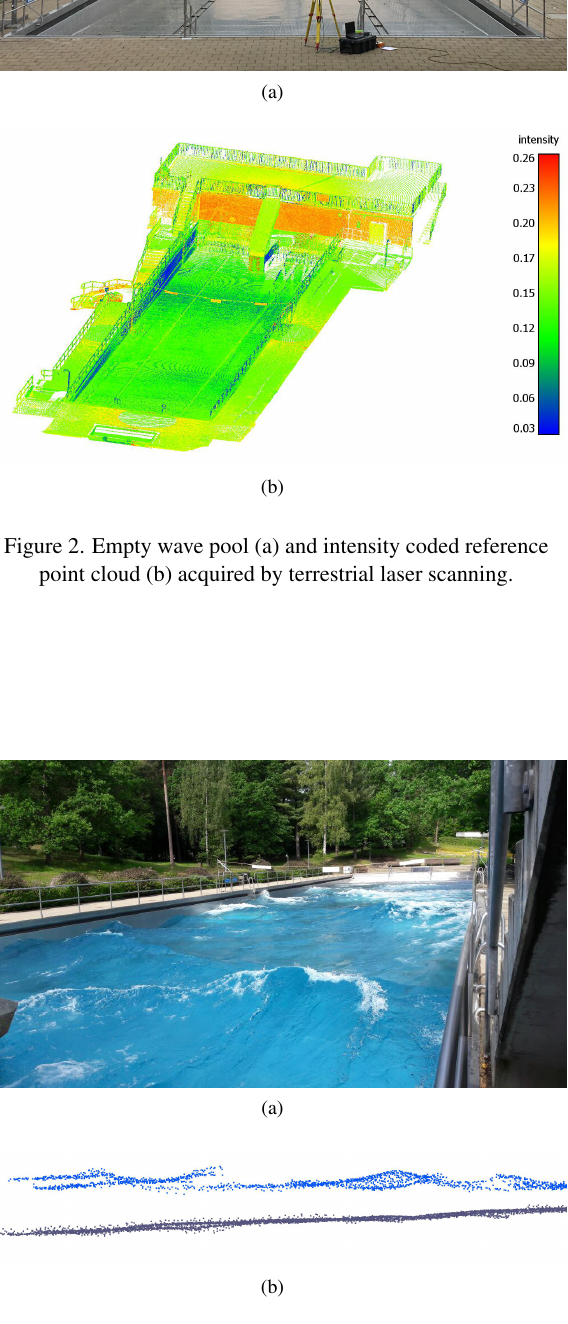
Figure 3. Swimming pool with artificial waves generated by a wave machine (a) and ALB point cloud (b) with water surface points in blue and water bottom points in